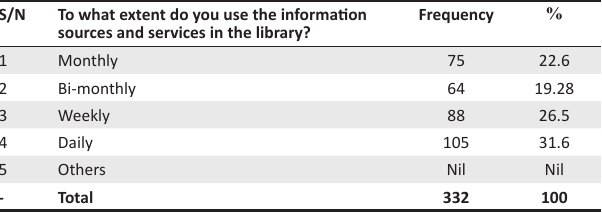
TABLE 12: Opinions of the library users on the extent of utilisation of information sources and services among rural dwellers from the libraries ( N = 332). S/N